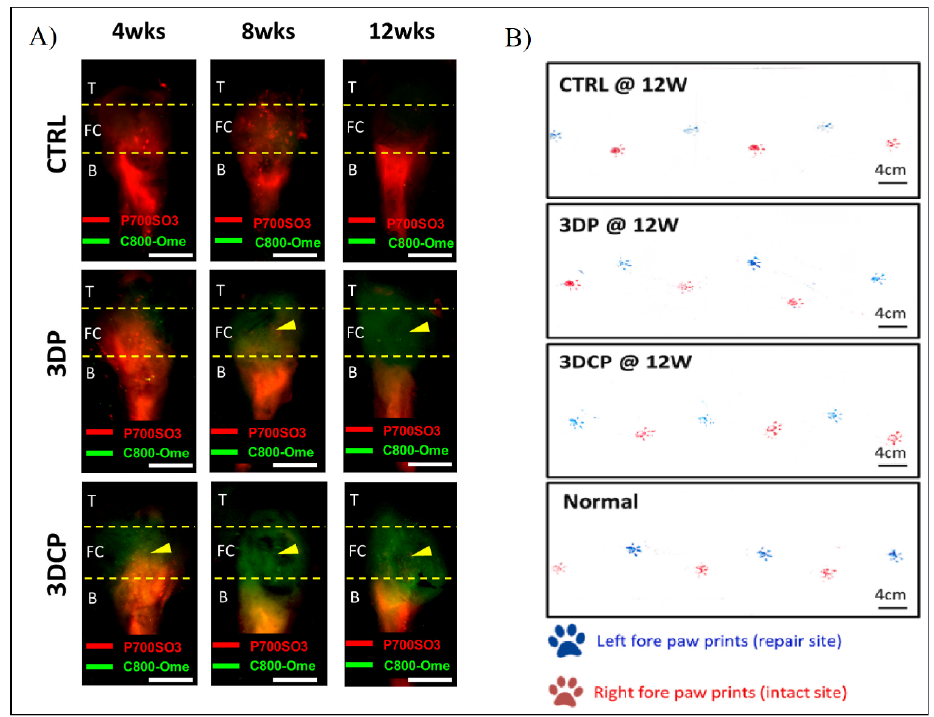
Figure 13. ( A ) Fluorescent evaluation of dECM tendon–bone scaffold for RC regeneration in control (CTRL), decellularized scaffold (3DP), and recellularized scaffold (3DCP) after 4, 8, and 12 weeks post-operation. ( B ) Gait analysis after 12 weeks post-operation of the left paw (blue, repair site) and right paw (red, intact) of CTRL, 3DP, and 3DCP after 12 weeks, and normal steps. Adapted from [80].